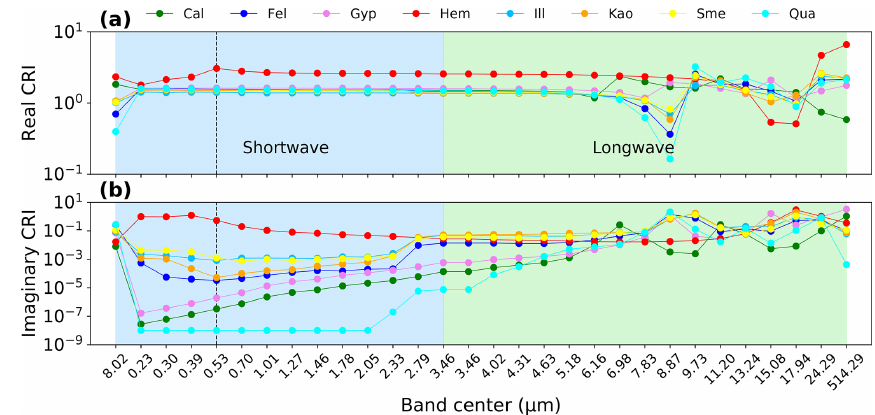
Figure 1. Real (a) and imaginary (b) complex refractive index (CRI) of each mineral for shortwave (blue shading) and longwave (green shading) bands (band centres shown as x -axis labels) implemented in CAM5/6. CRI values were derived for each band with original data taken from Scanza et al. (2015). The imaginary CRI of goethite was assumed to be half of hematite with the same spectral shape, while the real part of goethite is assumed to be identical to that of hematite. Vertical dash lines indicate the shortwave Band 10 centered at 0.53µm at which DOD and SSA for CAM5/6 were calculated. Note that the band centered at 8.02µm (leftmost) is broad, with low and high boundaries of 3.84 and 12.20µm, respectively. This broad band has been included in the model as shortwave bands by model developers. For mineral names, see text in Sect.